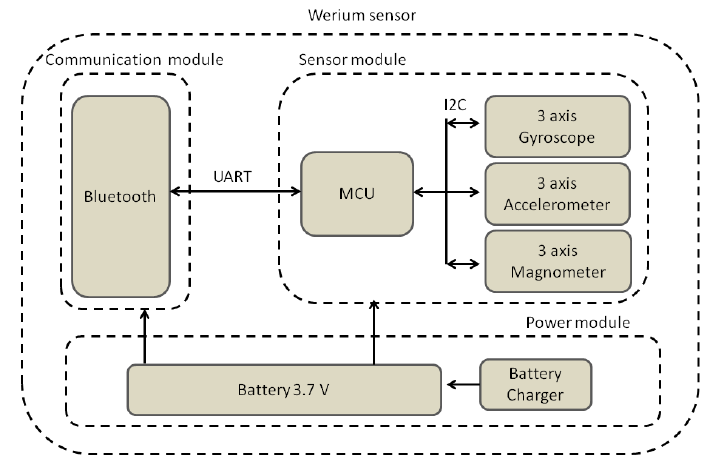
Figure 3. Sensor block